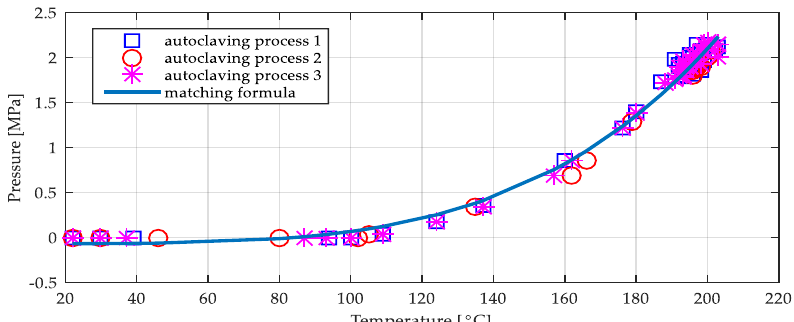
Figure 7. Autoclaving conditions used in laboratory setting during the brick production (3 processes with 10 elements